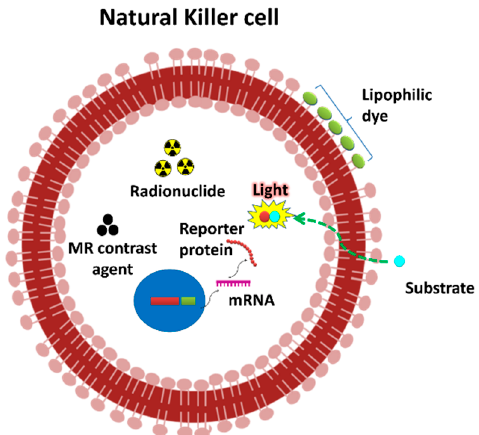
Figure 1. Labeling strategies of the NK cell for non-invasive imaging. At first, reporter genes (Firefly luciferase) are transduced to NK cells. Then, NK cells express the reporter protein. Lipophilic labeling agents (e.g., DiD, DiR and cy5.5) could bind to the membrane of the NK cells. 111 In-oxine and 99m Tc-oxine are lipophilic and penetrate the membrane of cells. [ 18 F]FDG can be transported into cells via glucose transporters. NK cells can be electroporated or incubated with molecules such as ultra-small super paramagnetic iron oxide (USPIO).